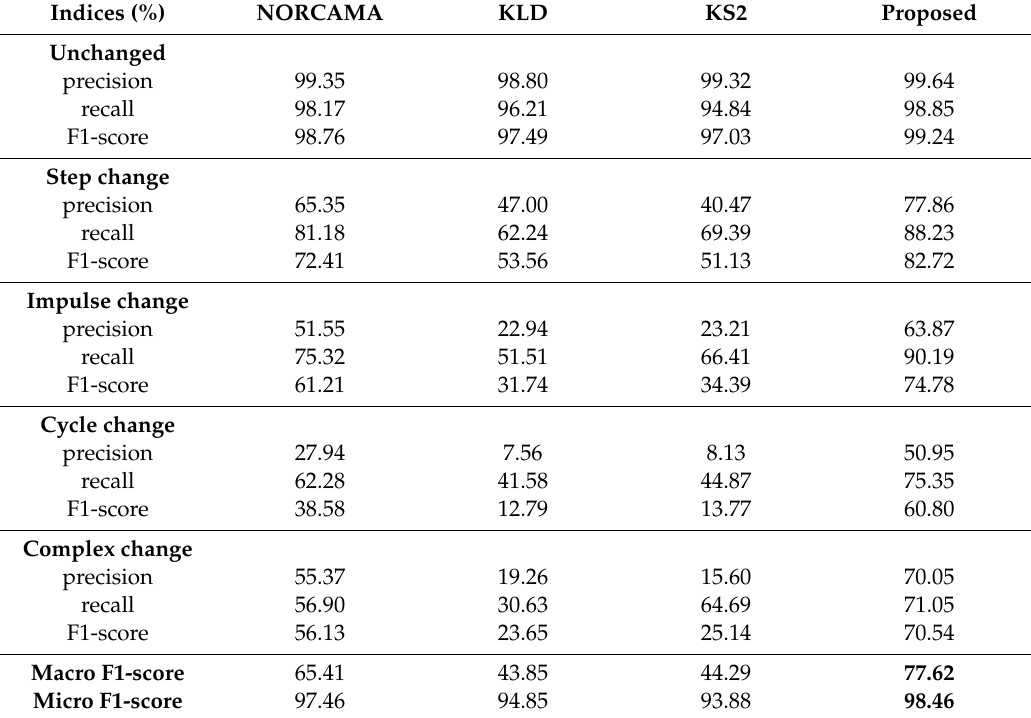
Table 6. Quantitative comparison of change classification accuracy for di ff erent methods in the realistic case.